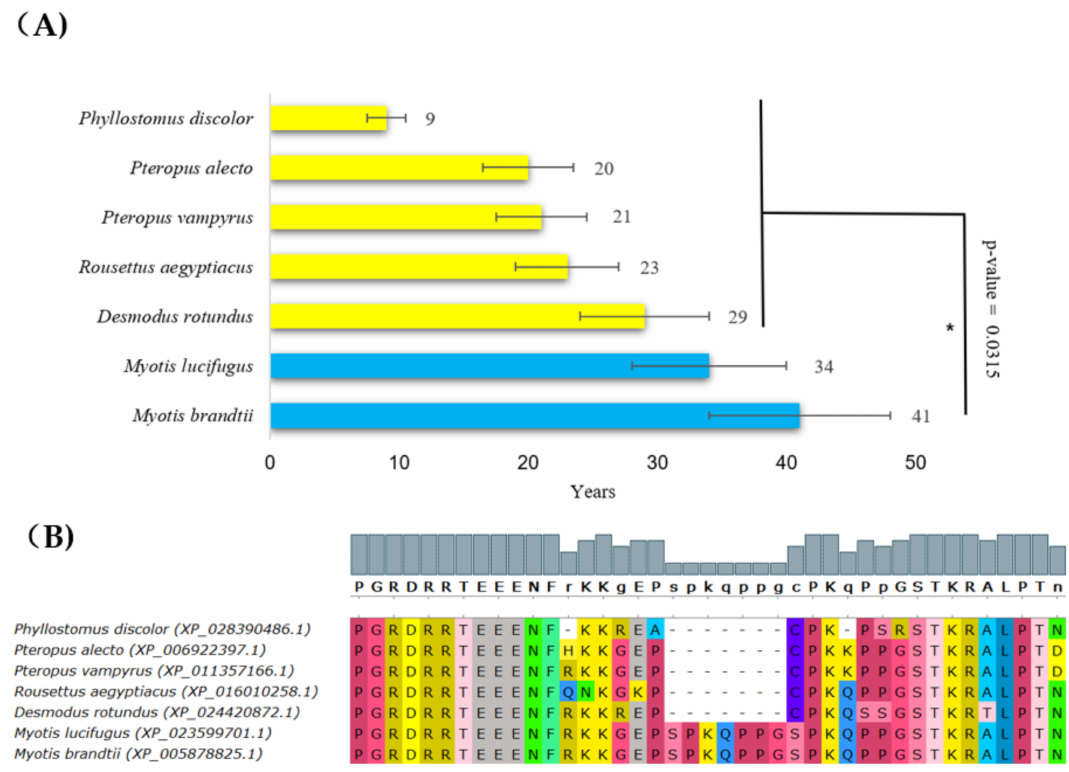
Figure 4. Lifespans of species in the Chiroptera order and the corresponding p53 sequence changes. ( A ) Comparison of Chiropteras’ maximal lifespans in years. The bats’, Myotis brandtii ’s and Myotis lucifugus ’s maximal lifespans were significantly longer compared with other sequenced bats (Wilcoxon one-sided signed-rank test, * p -value < 0.05). ( B ) Multiple protein alignments of the C-terminal part of the p53 core domain of accessible Chiroptera sequences. Methods and color schemes are the same as in Figure